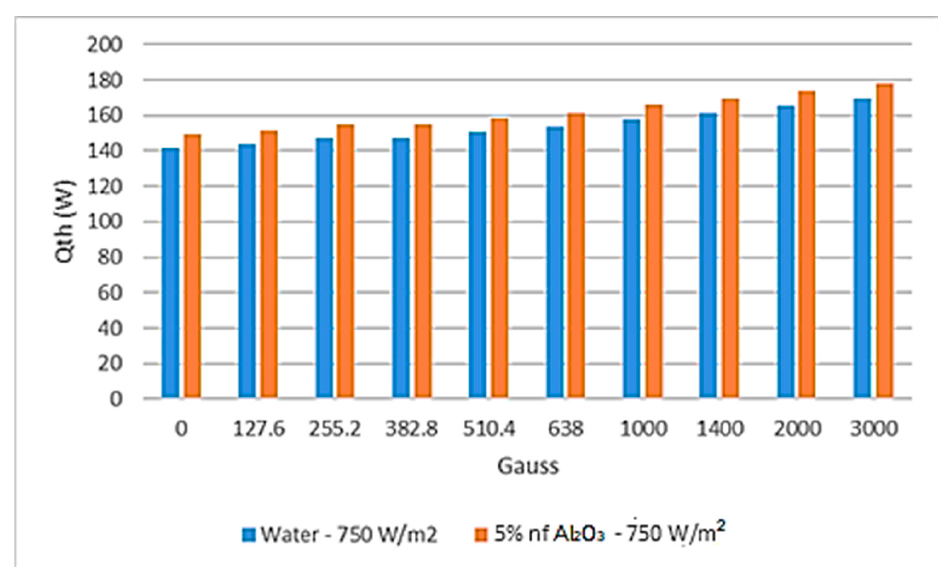
Figure 9. Thermal energy is generated by PV-Th solar panels with a different magnetic field.